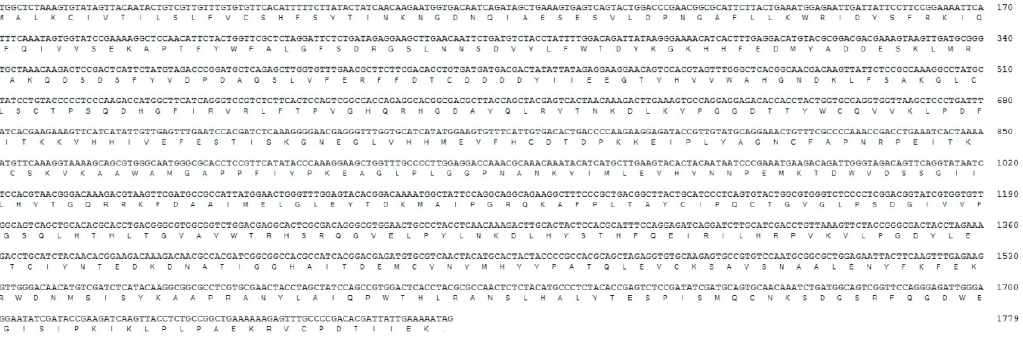
Figure 2. cDNA and deduced amino acid sequence of M. separate T β h .